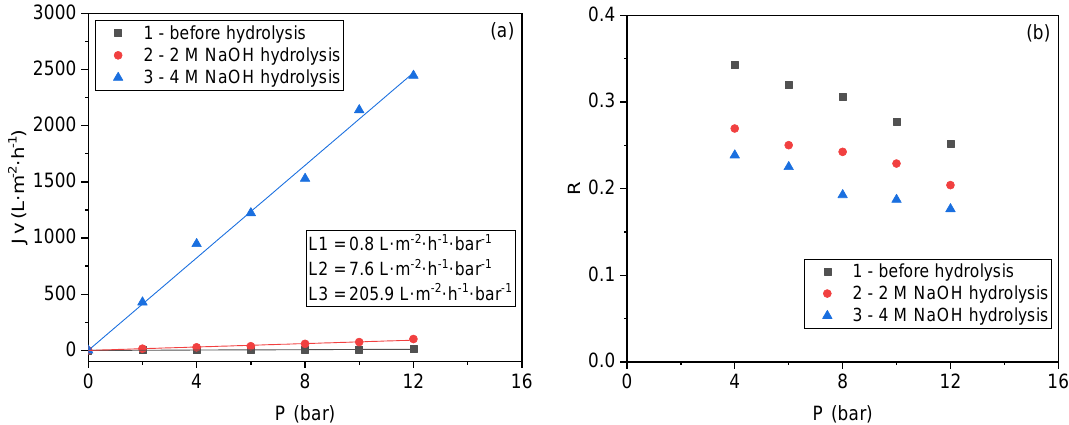
linked polysulfone carboxylated.